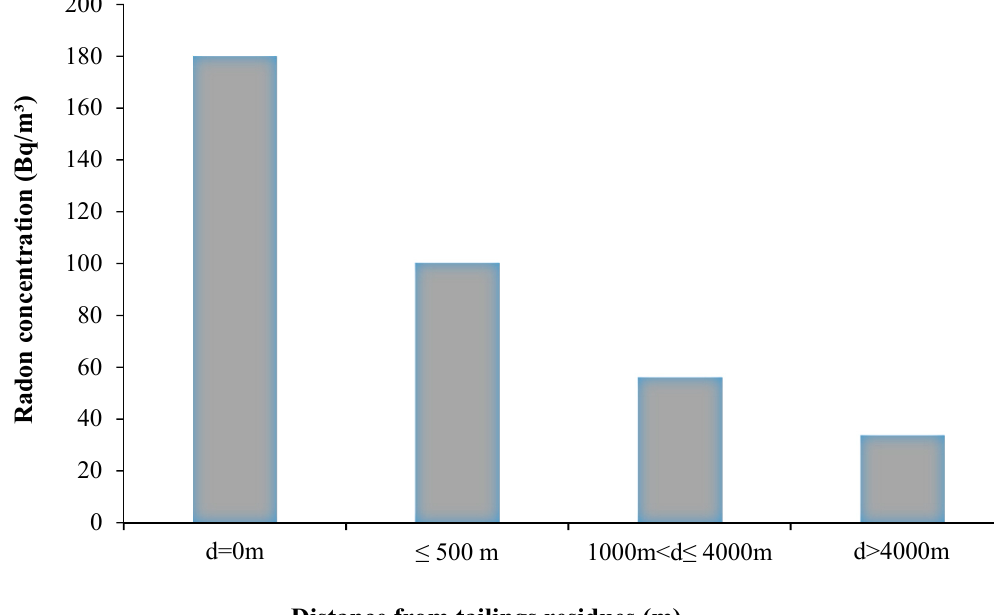
Figure 4. Tailings dam found in the study area contributing to high radon levels.